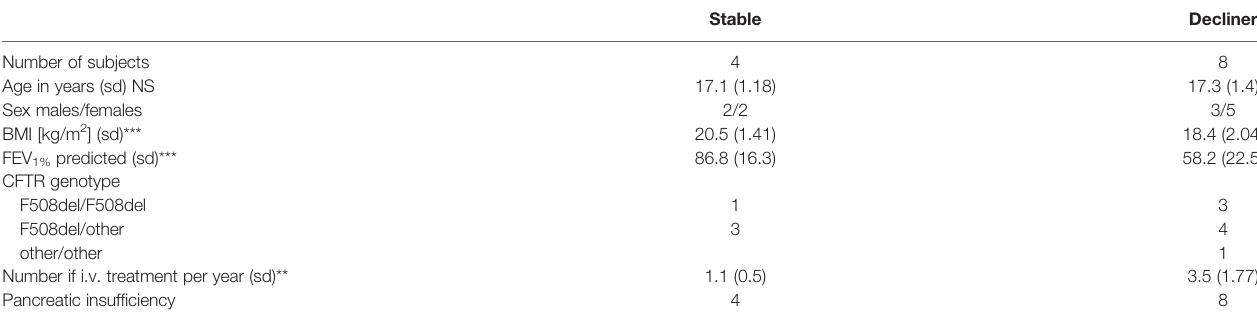
TABLE 1 | Clinical characteristics of patients with cystic fi brosis.